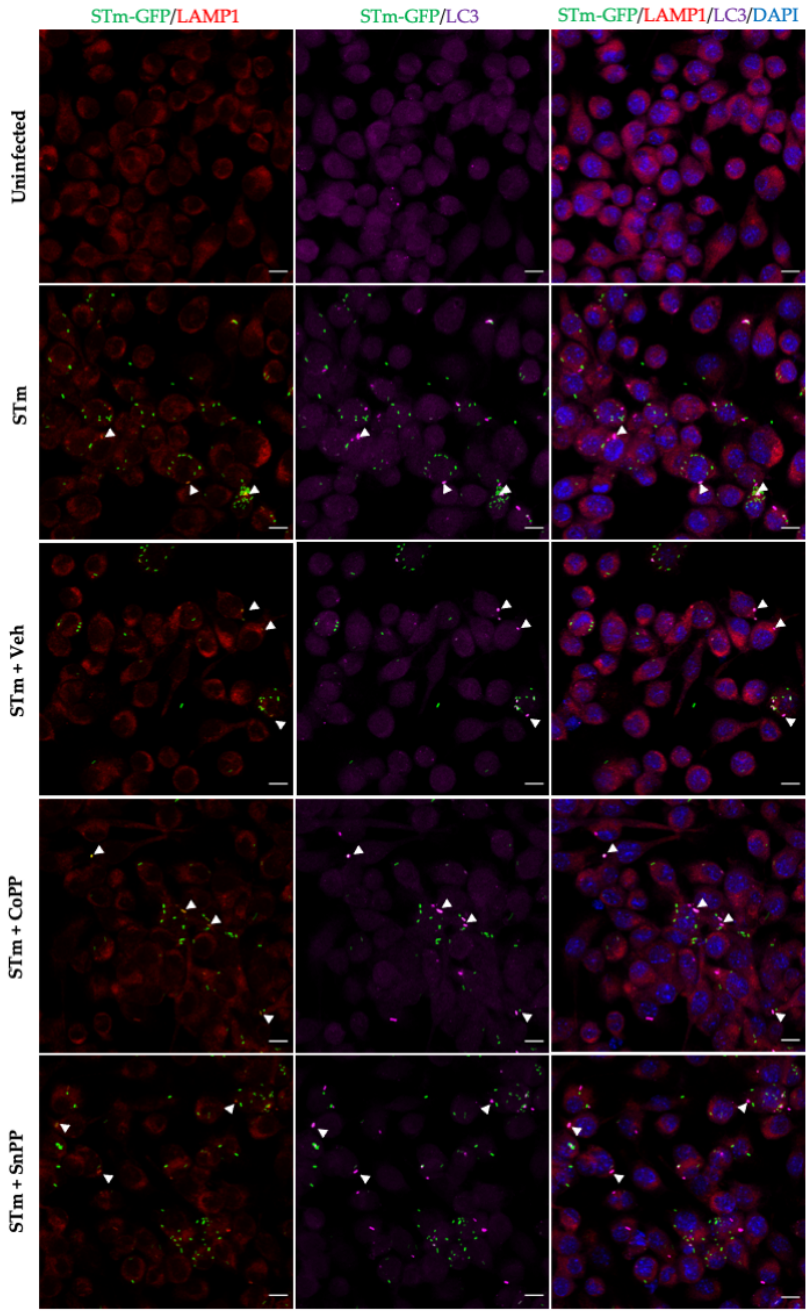
Figure 6. Co-localization of S . Typhimurium-GFP with autophagosome and lysosome markers in infected RAW264.7 cells. RAW264.7 cells were infected with STm-GFP for 1 h and subsequently treated for 4 h in the presence of vehicle (NaOH), CoPP, or SnPP. LC3: red; LAMP-1; magenta; DAPI: blue. STm-GFP colocalization with both markers is shown in white arrowheads. Scale Bar: 10 µ m. Images are representative of two independent